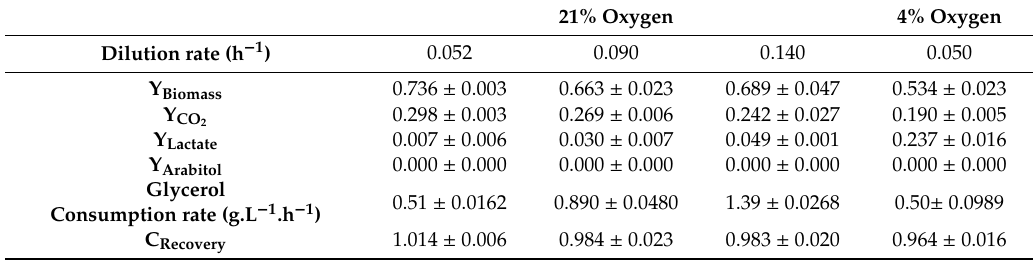
Table 3. Biomass, CO 2 , lactate, and arabitol yields (in Cmol / Cmol) and carbon recovery during steady-state of glycerol-limited chemostat cultures performed at di ff erent dilution rates (Dsp) and under two aeration conditions (% of oxygen in the inlet gas flow). Experiments were performed in duplicate for each steady-state and results are displayed as the average ± deviation of the